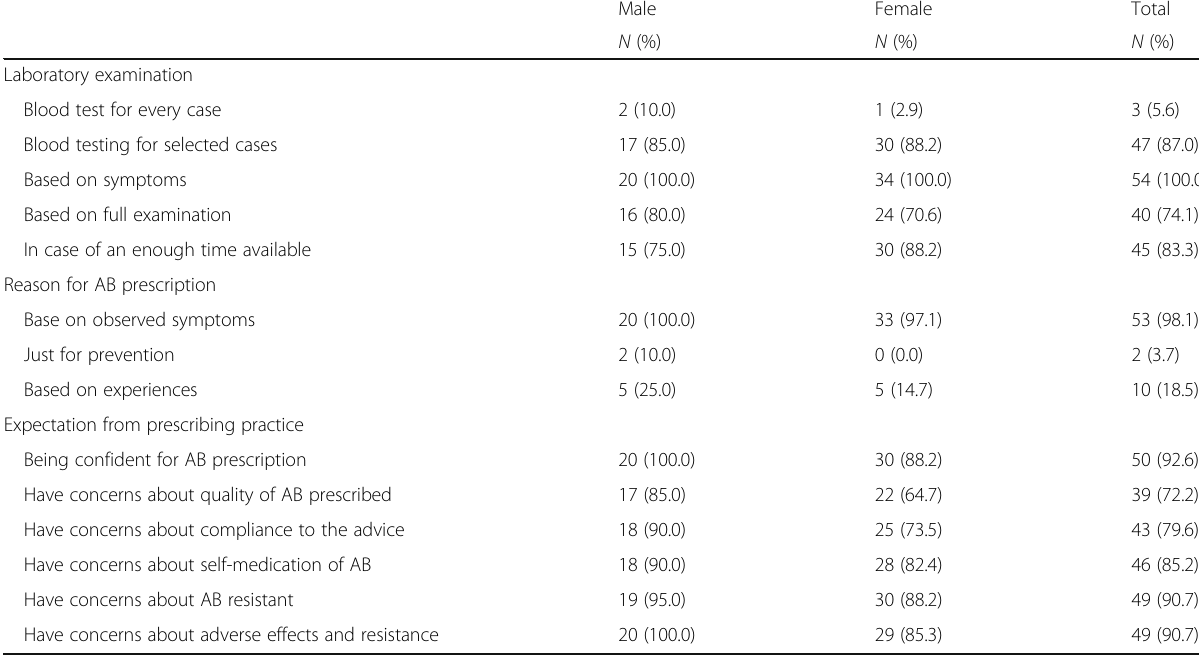
Table 3 Prescription practices and expectation on prescription among healthcare providers (20 males and 34